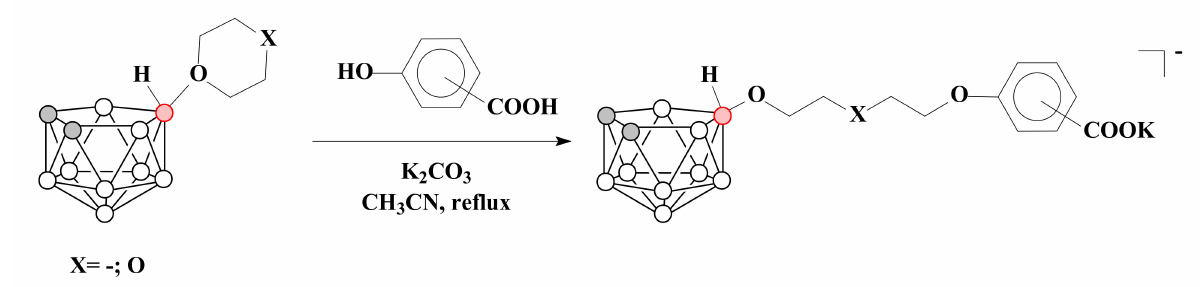
Scheme 3. The synthesis of nido -carborane derivatives with terminal carboxylic